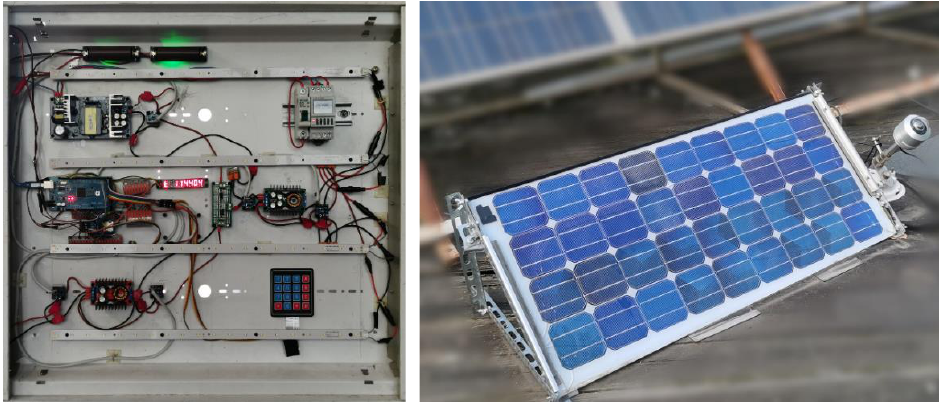
Figure 4. Elements of the developed system.